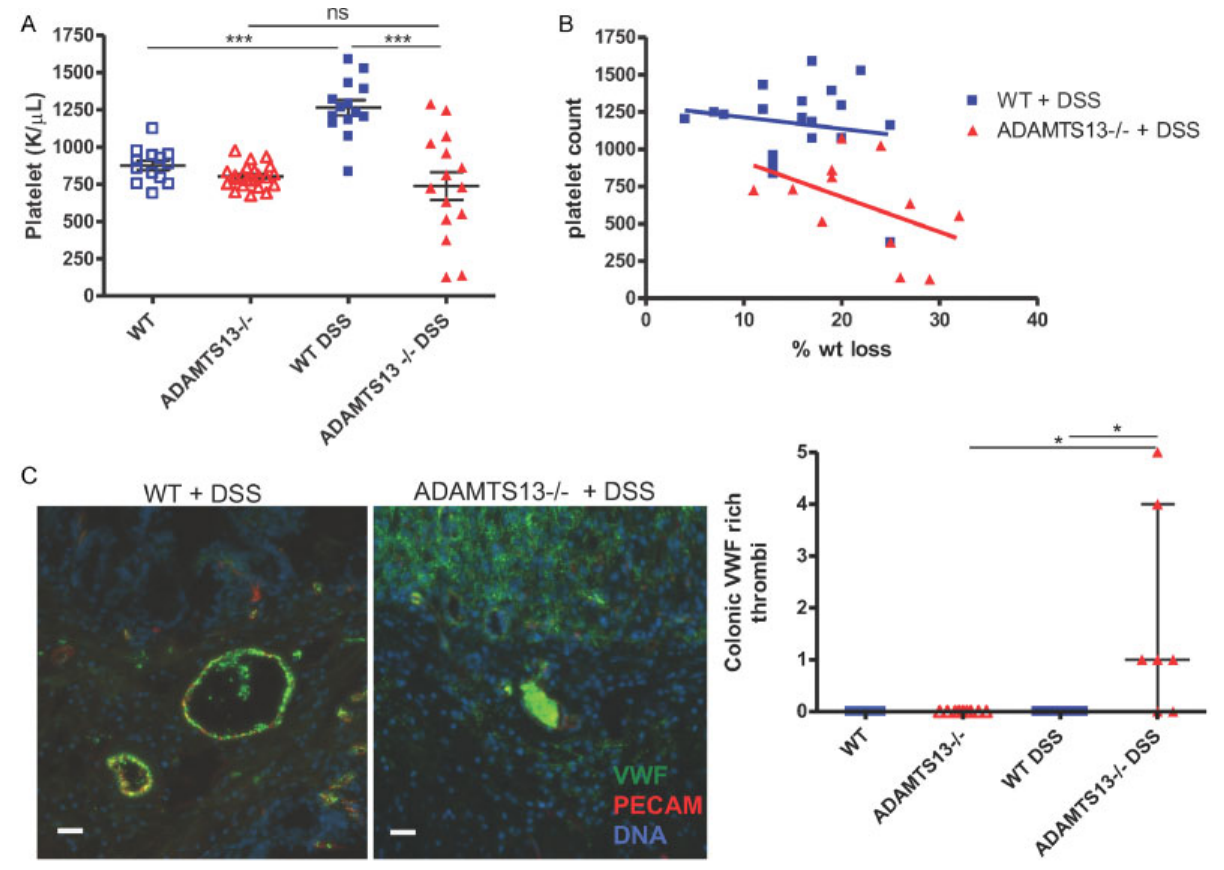
Fig. 1 Effects of ADAMTS13 de fi ciency on platelet count and colonic thrombosis. ( A ) Platelet counts for WT and ADAMTS13 (cid:1) / (cid:1) mice without colitisdid not differ.Withcolitis, there wassigni fi cant thrombocytosisinWT mice, while in ADAMTS13 (cid:1) / (cid:1) mice platelet count varied more widely but hadasimilar mean to baseline. ( B ) Platelet counts trended to belower inmice with more weight loss, an indicator of worse colitis, and tended to decrease more inADAMTS13 (cid:1) / (cid:1) mice with colitis(slopes p ¼ 0.12). ( C ) Colons from WT andADAMTS13 (cid:1) / (cid:1) mice were fl uorescently stained for VWF (green), PECAM-1 (red), and DNA (blue). In WT mice, we observed increased VWF expression mostly within the vessel wall with likely some VWF-positive platelets in the lumen. In contrast, in most ADAMTS13 (cid:1) / (cid:1) mice, we found a completely occlusive VWF-rich thrombus in a submucosal vessel. Entire Swiss-rolled sections of colon were inspected for thrombi. We found one or more VWF-rich thrombi in most ADAMTS13 (cid:1) / (cid:1) colon sections and none in WT colons with colitis. In ( A ), mean and SEM are shown. In ( C ), median (cid:4) IQR values are presented. (cid:5) p < 0.05, (cid:5)(cid:5) p < 0.005, (cid:5)(cid:5)(cid:5) p < 0.0005.